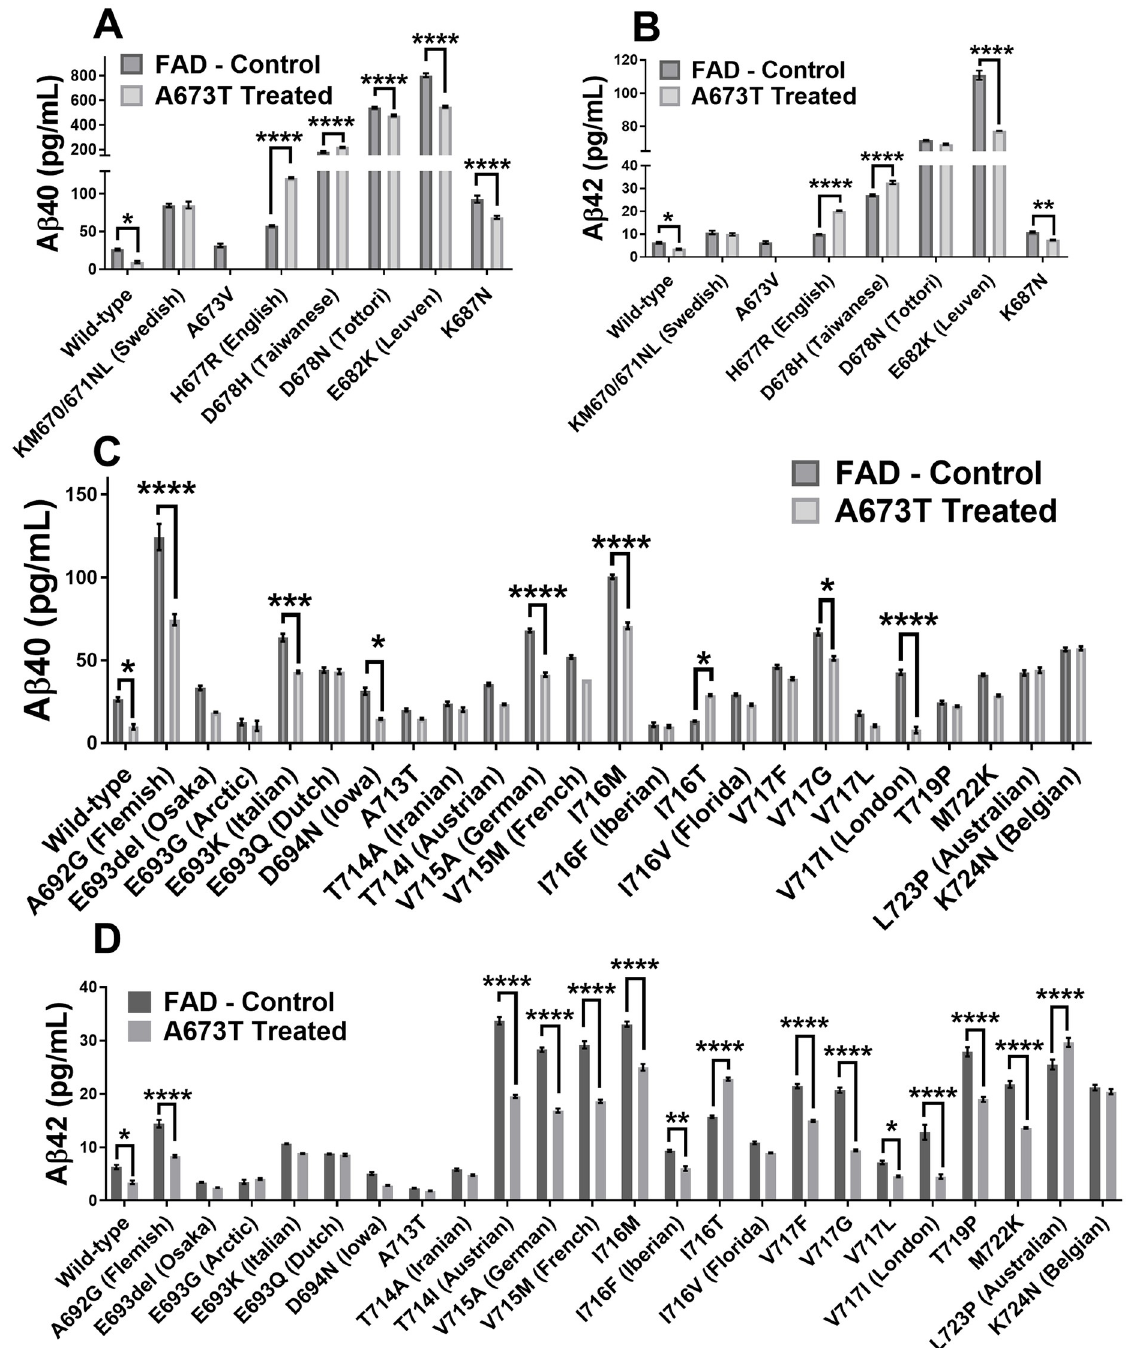
Fig 3. A β peptide concentrations in culture medium. Neuroblastomas were transfected with plasmids coding for 30 FAD mutations with or without an additional Icelandic (A673T) mutation (except for A673V). A β 40 concentration ( A ) and A β 42 concentration ( B ) when various FAD mutations are present in exon 16. A β 40 concentration ( C ) and A β 42 concentration ( D ) when various FAD mutations are present in exon 17. Statistical test: two-way ANOVA Sidak’s multiple comparisons test (n = 6). P value style � p < 0.0332, �� p < 0.0021, ��� p < 0.0002, ���� p <